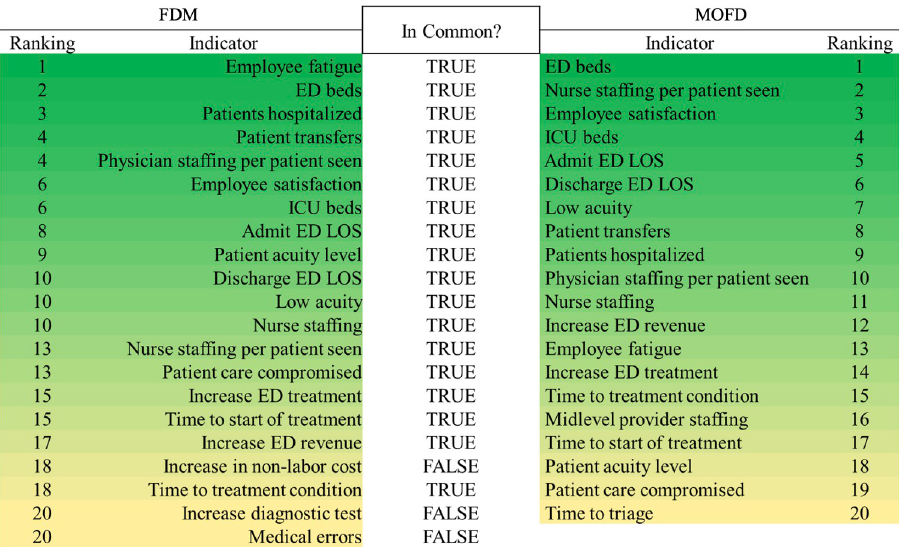
Fig 2. Ranking and comparison of indicators for the FDM and MOFD method,